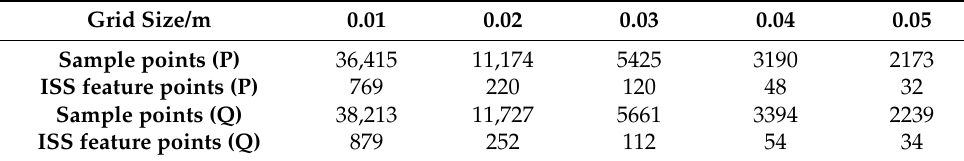
Table 1. The number of sampling points and feature points under different grid sizes.